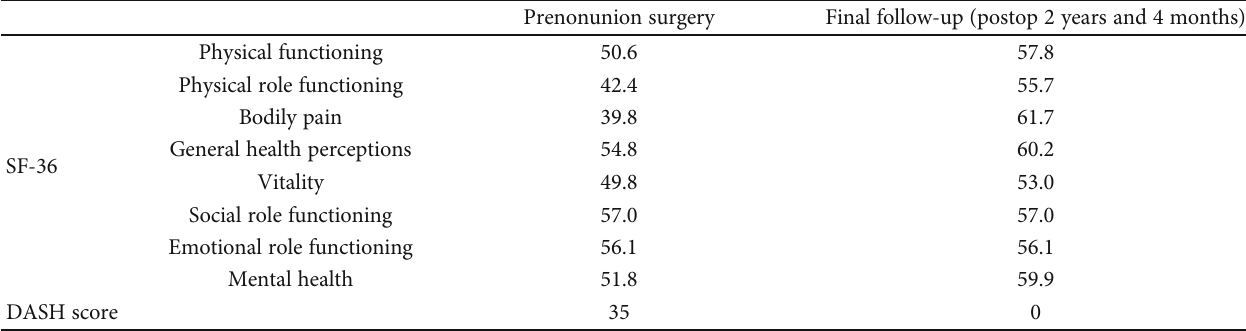
Figure 9: Range of motion of the left shoulder and elbow joints was not limited at the fi nal follow-up 2 years and 4 months postoperatively. Table 1: The SF-36 score and DASH score at the prenonunion surgery and fi nal follow-up. Higher SF-36 and lower DASH scores indicate better status and function. The QOL and the upper limb function were notably improved at the fi nal follow-up compared with the prenonunion surgery